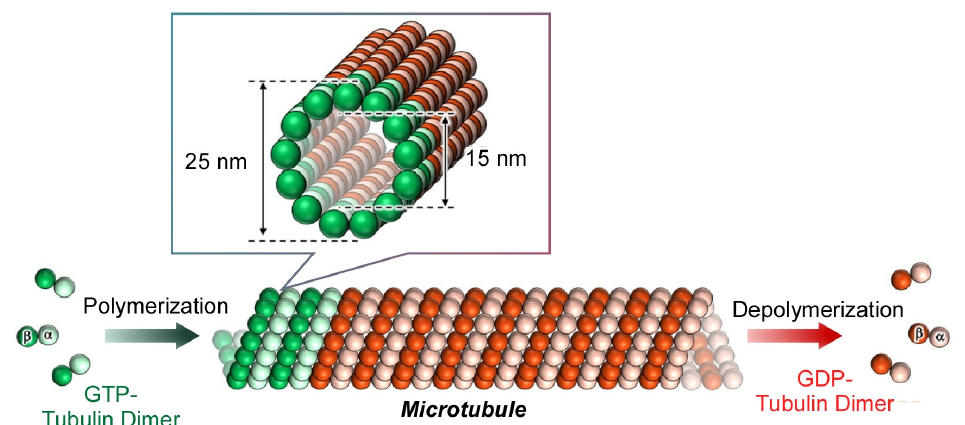
Figure 11. Biological microtubules formed through dynamic polymerization and depolymerization of tubulin dimers. Reprinted with permission from Reference [140]. Copyright 2021 Chemical Society of Japan.